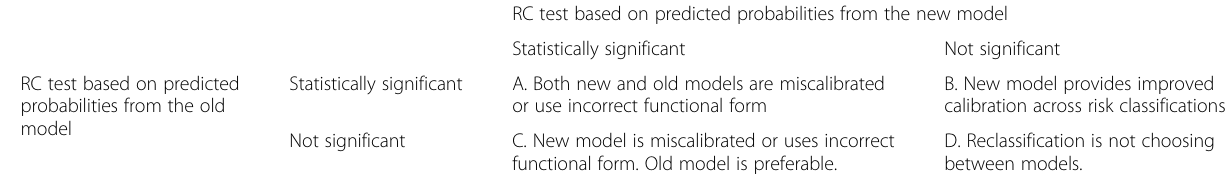
RC test based on predicted probabilities from the new